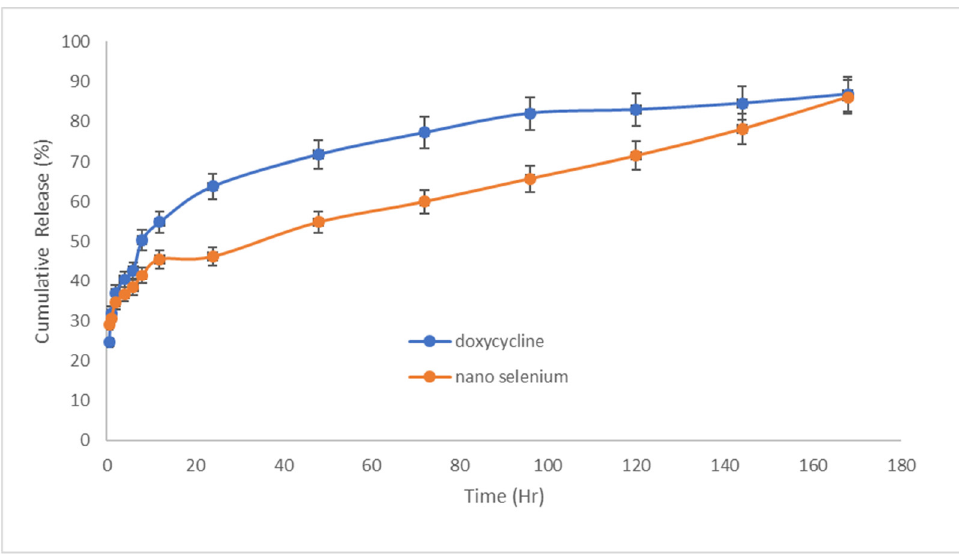
Figure 5. Doxycycline and SeN were released from the transdermal patch at 32 °C and pH = 7.4 ( n = 3).